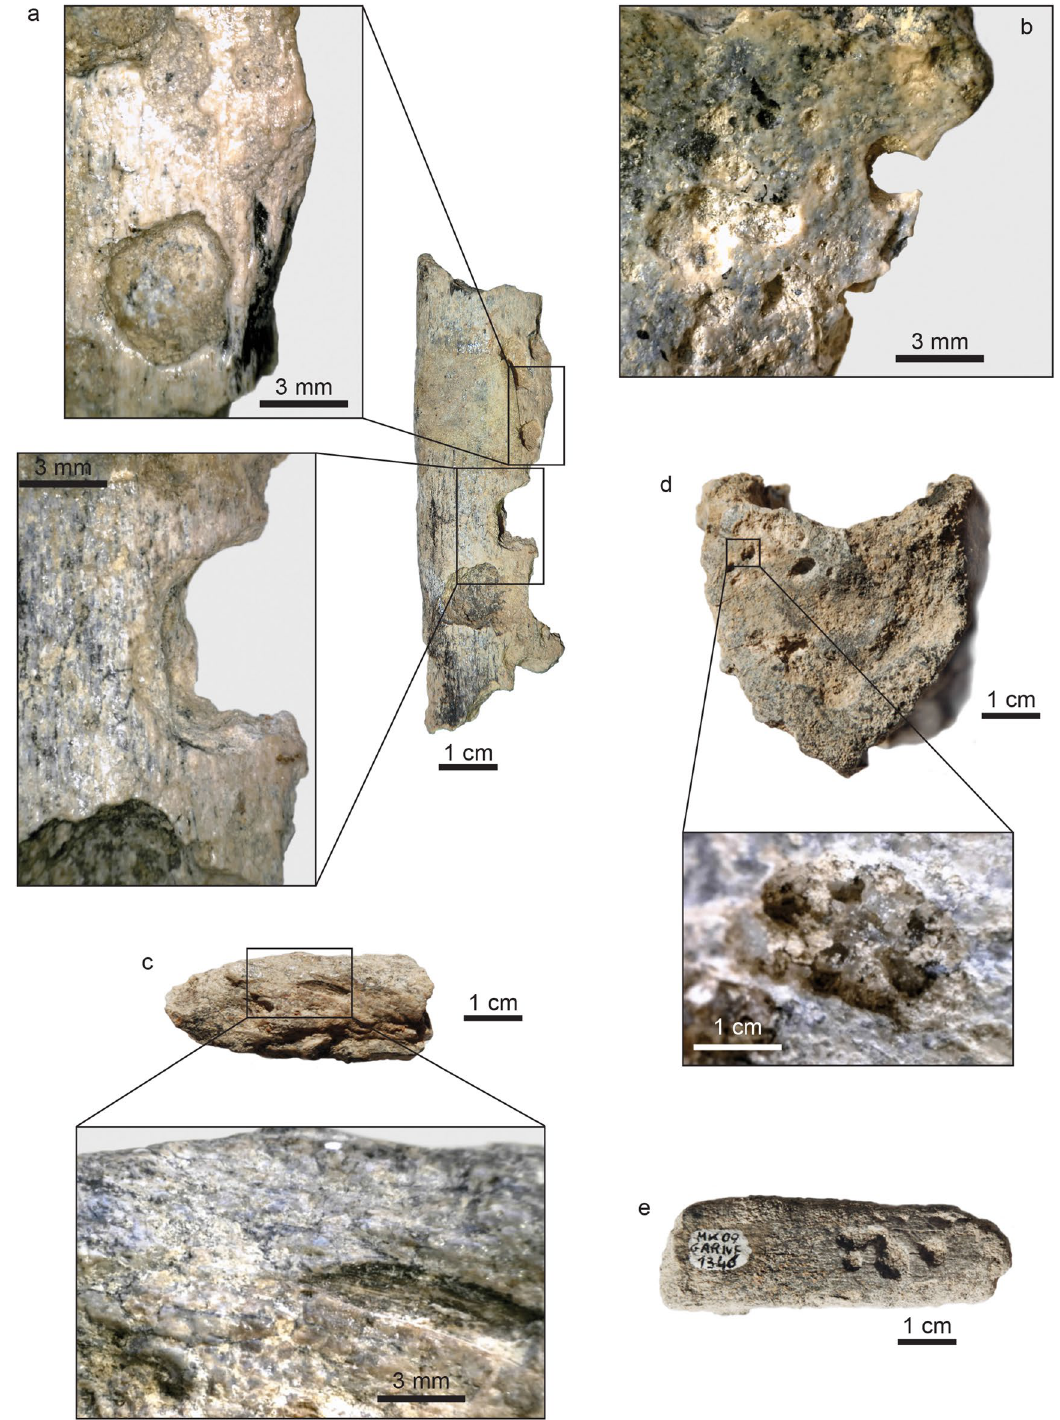
Figure 6. High quality photographs of faunal bone specimens from Garba IVE showing typical modifications left by dermestids. (A) Garba IVE 05-40, Garba IVE 05-57, Garba IVE 05-59, Garba IVE 05-32, Garba IVE